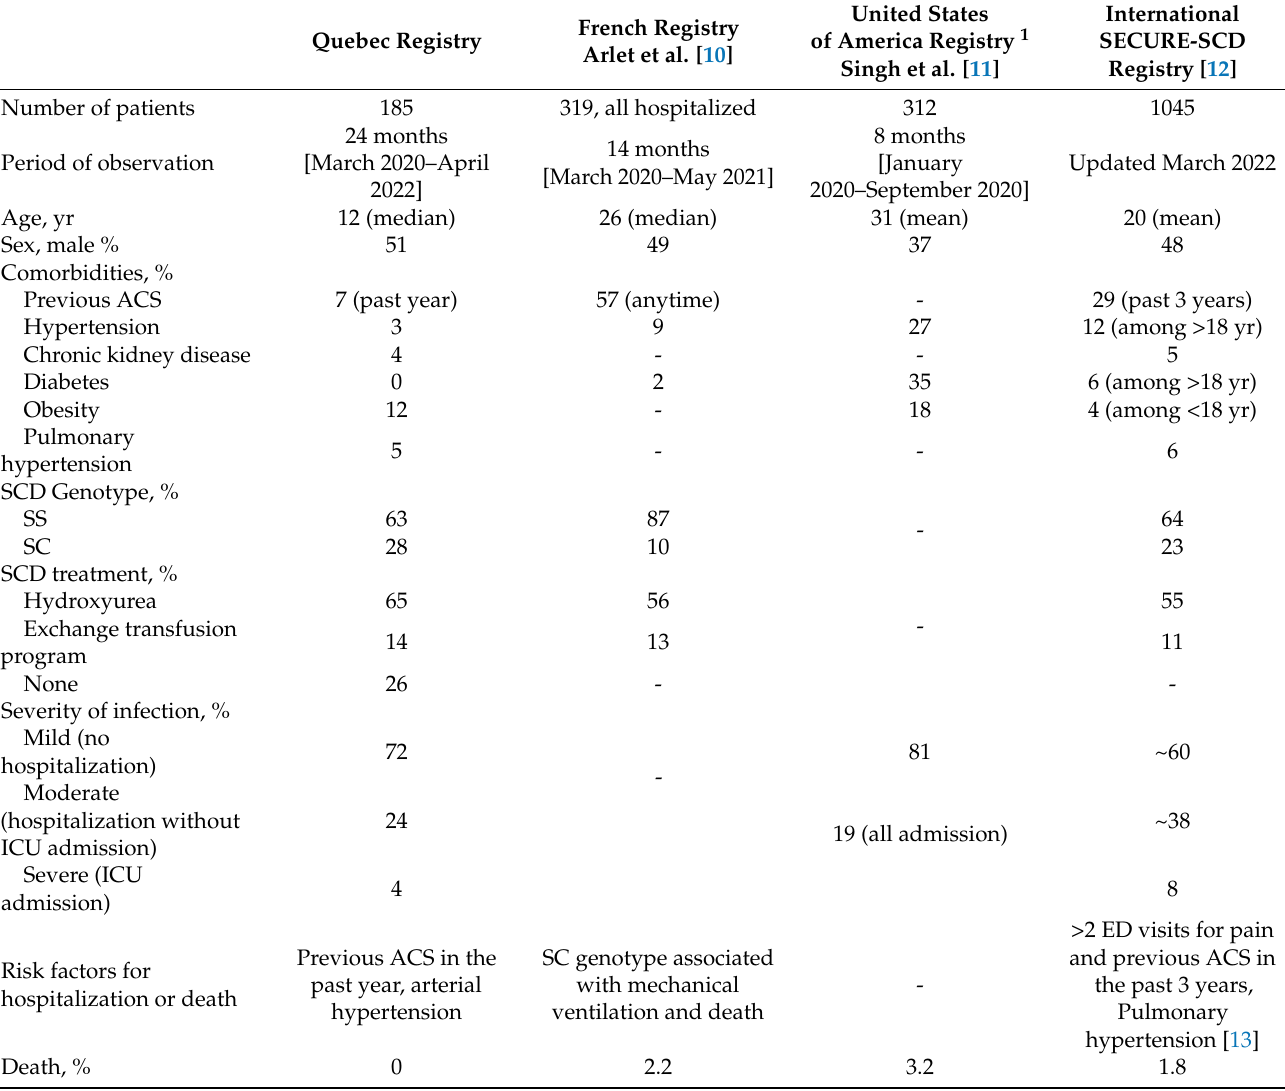
Table 6. Comparison of the Quebec SCD—COVID-19 population to the French, United States of America, and SECURE-SCD